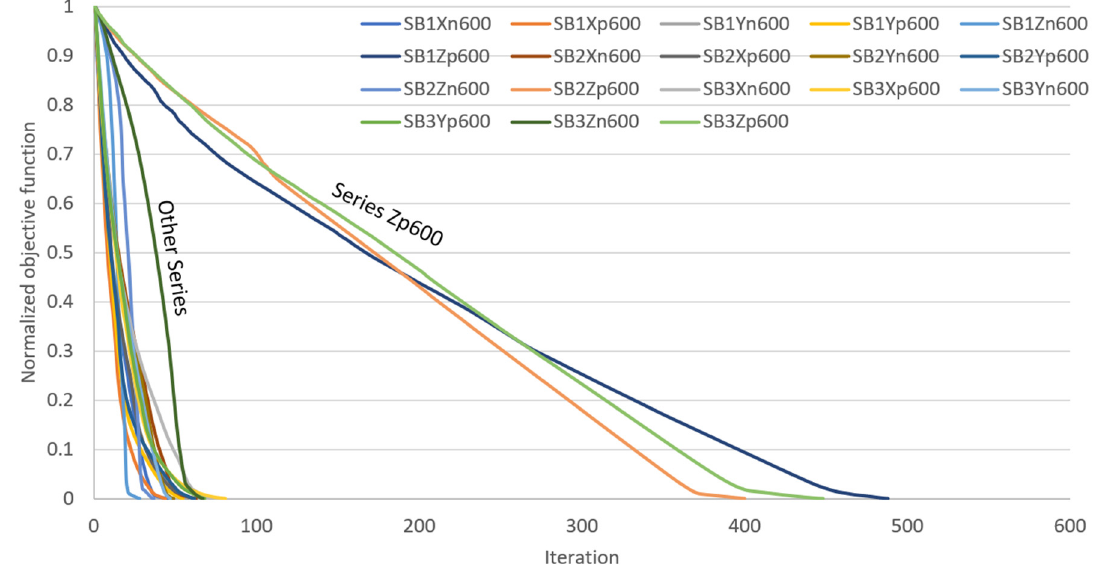
Figure 11. Convergence history for 18 cases with the uni-directional mode with target displacement of 600 mm.